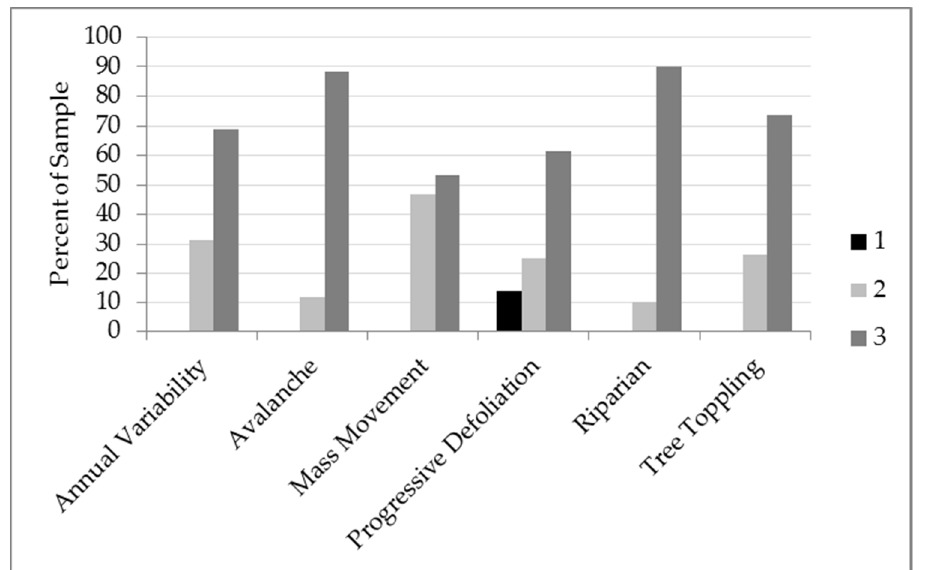
Figure 6. Distribution of confidence values among change categories for labels assigned in the field for randomly selected patches.